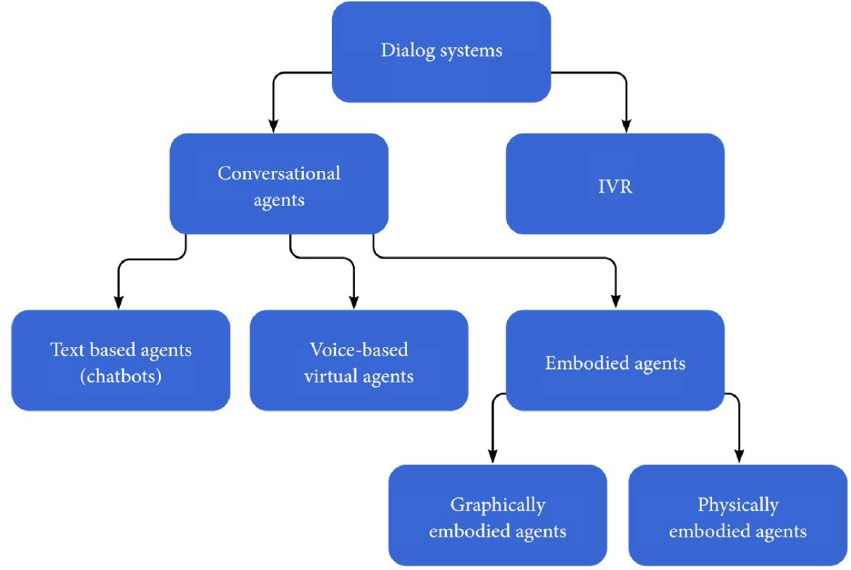
Figure 1. Conversational agents and chatbots: the definitions used in this article. CAs can also be classified according to their effector capabilities and